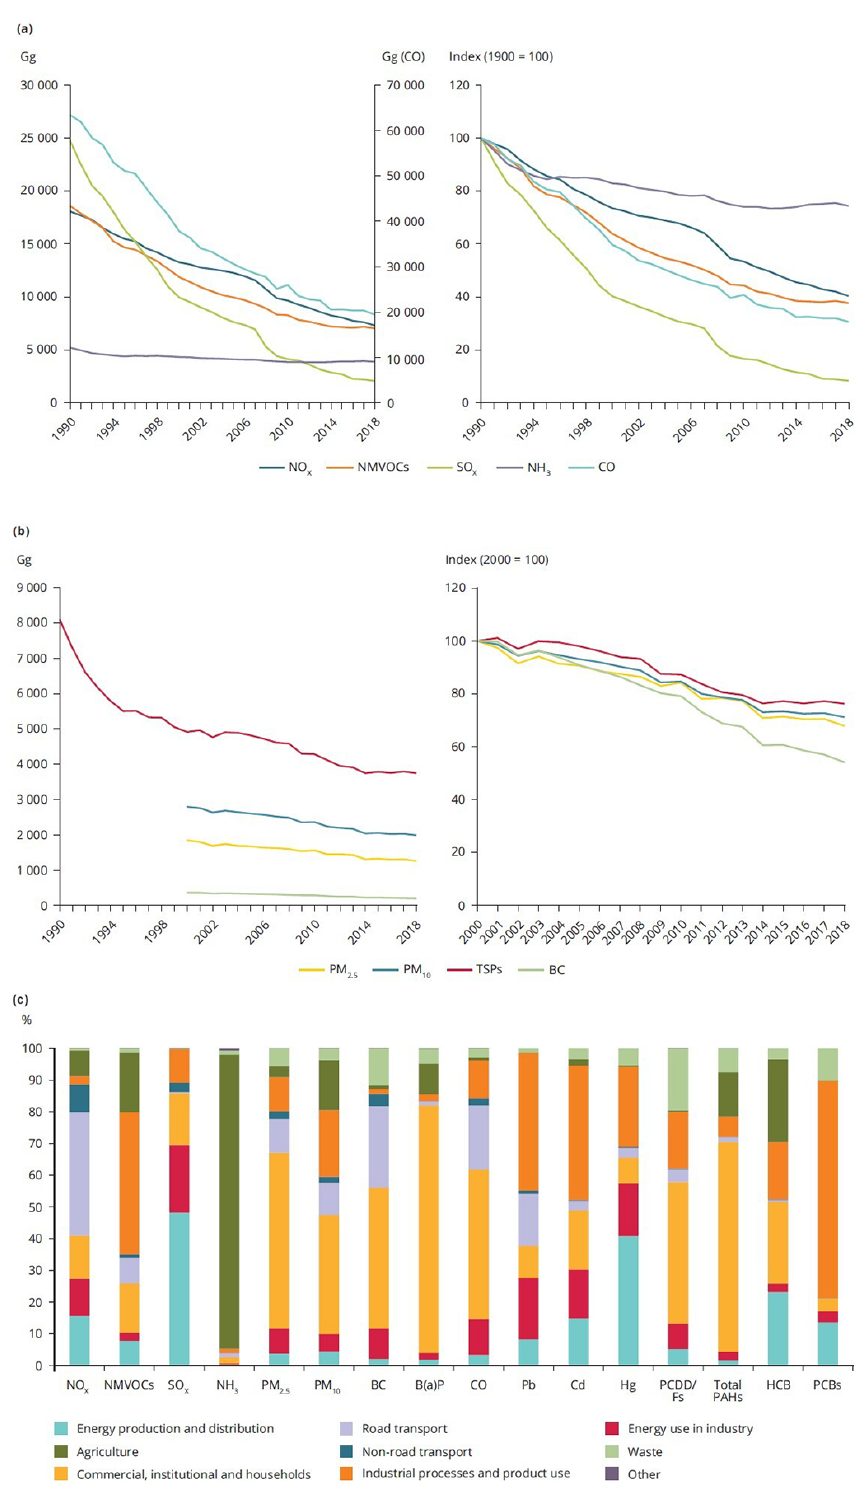
Figure 2. EU-28 emission trends in absolute and relative numbers for (a) the main gaseous air pollutants and (b) particulate matter. Panel (c) shows the share of EU emissions of the main pollutants by sector in 2018 (EEA, 2020b).